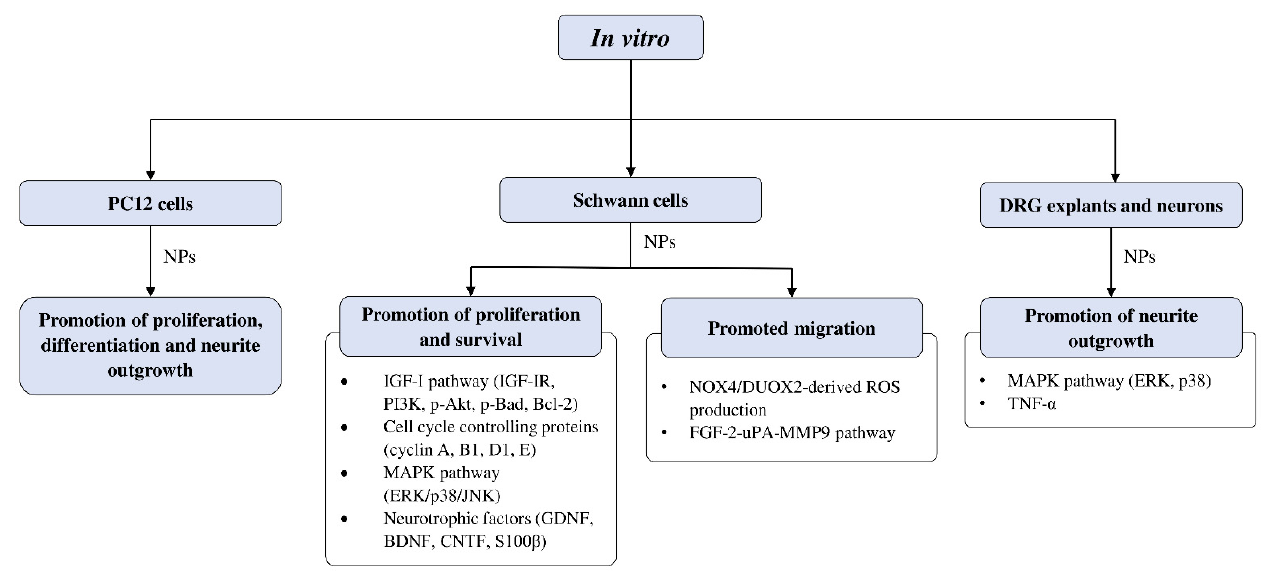
Figure 4. Overview of in vitro studies that demonstrated the effects of natural products relating to peripheral nerve regeneration across different cell types with associated mechanisms. Akt—protein kinase B; Bad—Bcl-2 associated agonist of cell death; Bcl-2—B-cell lymphoma 2; BDNF—brain-derived neurotrophic factor; CNTF—ciliary neurotrophic factor; DRG—dorsal root ganglion; DUOX2—dual oxidase 2; ERK—extracellular signal-regulated kinase; FGF—fibroblast growth factor; GDNF—glial cell-derived neurotrophic factor; IGF-I—insulin-like growth factor 1; IGF-IR—insulin-like